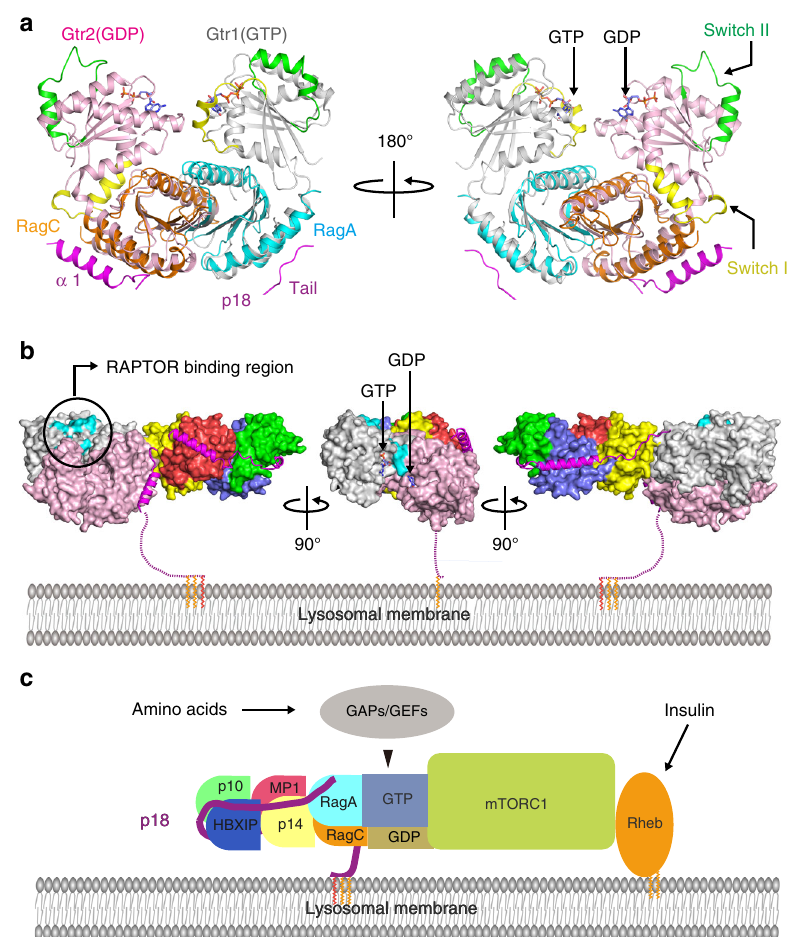
Fig. 6 Modeling of the functions of the Ragulator-Rag GTPase complex on lysosomes. a Ribbon model representation of the RagA(RD)-C(RD) structure superimposed on that of the Gtr1p-2p complex (left panel). The structure is viewed from different angles rotated at 180° along the vertical axis (right panel). The locations of switch I and II regions are indicated on the Gtr1p-2p complex, and are shown in yellow and green, respectively. b Model of the complete Ragulator-RagA-C complex anchored on the lysosomal membrane. p18 is shown in stick and ribbon representation on the molecular surface of the simulated Ragulator-Rag GTPase complex. The model is viewed from differential angles rotated at 90° along the vertical axis. The RAPTOR-binding region and GTP/GDP-binding sites are indicated. c Schematic model of mTORC1 activation by the Ragulator-Rag GTPase complex on